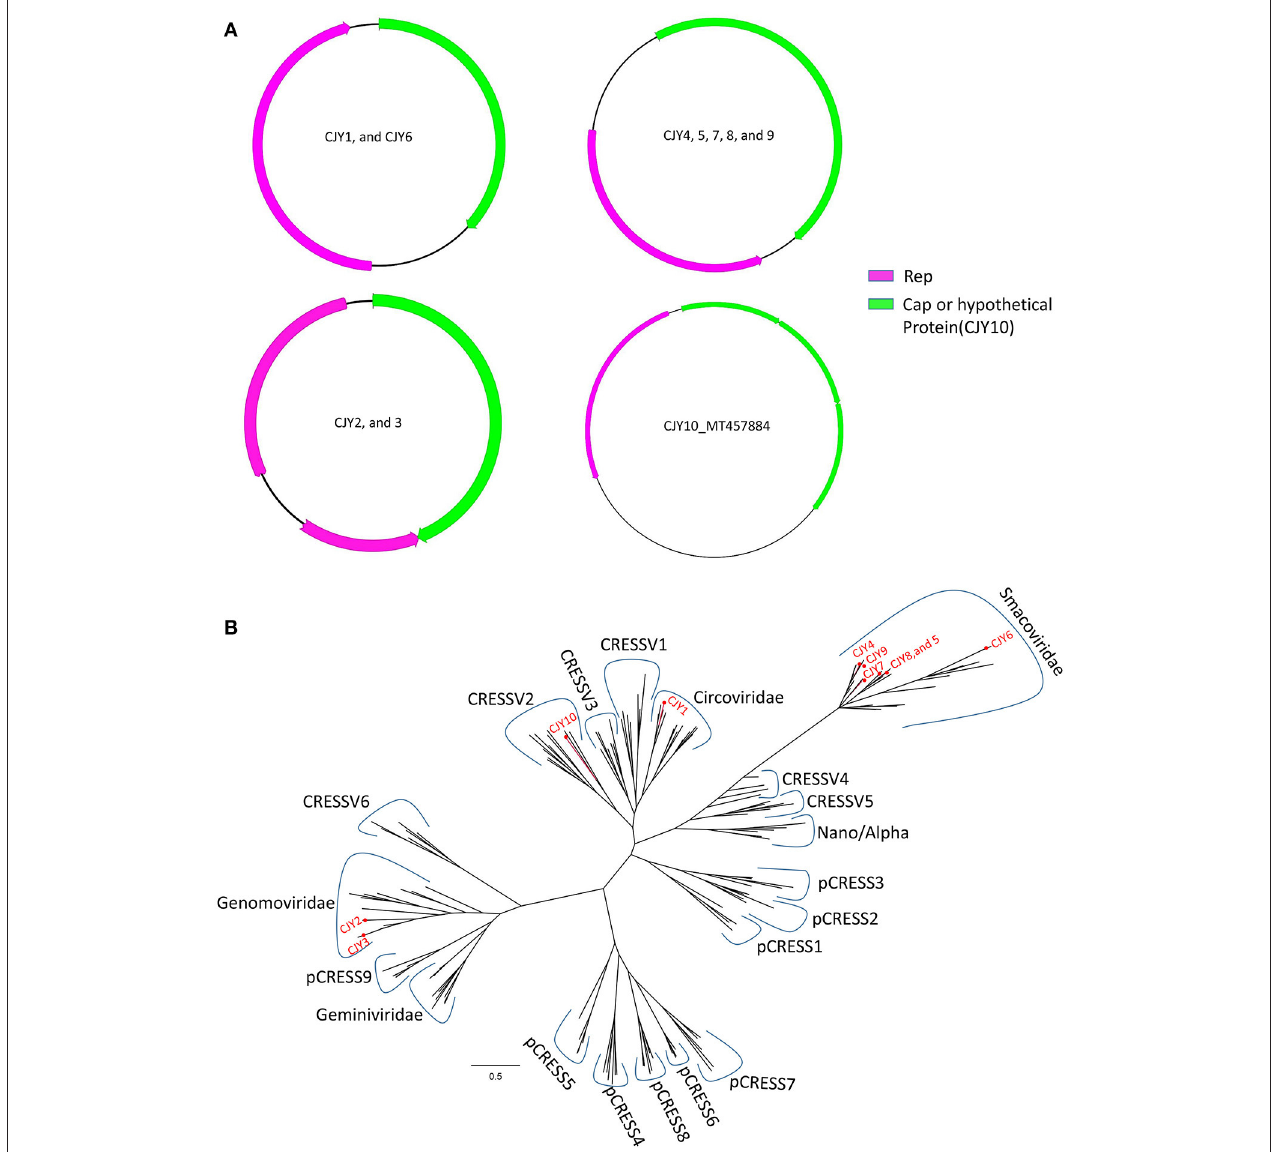
FIGURE 5 | Genomic organization and phylogenetic analysis of 10 CRESS-DNA viruses identified in raccoon dogs. (A) Genomic organization of CJY1-10. The Rep protein and Cap protein of CJY1-10 were separately marked with pink and green. The arrow indicated the direction of gene coding. (B) Phylogenetic analysis based on the amino acid sequences of Rep of CJY1-10 and reference strains of CRESS-DNA virus, unclassified CRESS-DNA virus (CRESSV1-6), and bacterial plasmids (pCRESS1-9). The CJY1-10 identified in this study was marked with a red solid